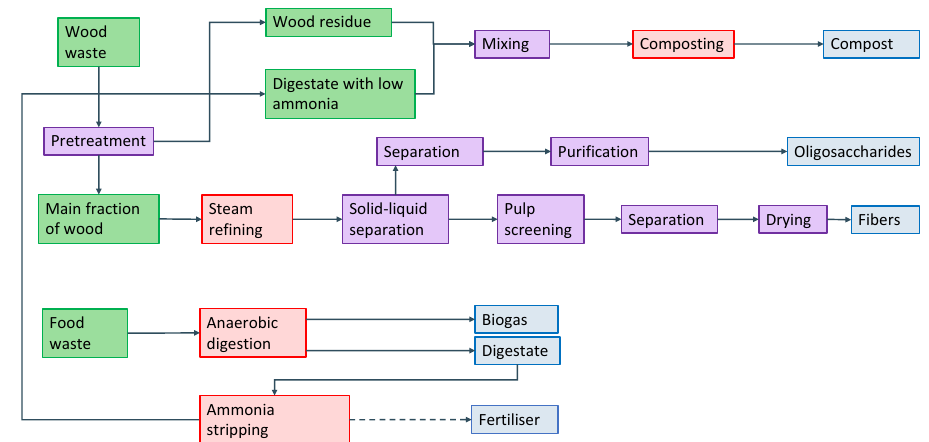
Figure 3. Schematic representation of the small-scale biorefinery modelled in this contribution. (Intermediate) Feedstocks are represented in green, main processes are represented in red, secondary processes are represented in purple, and (intermediate) products are represented in